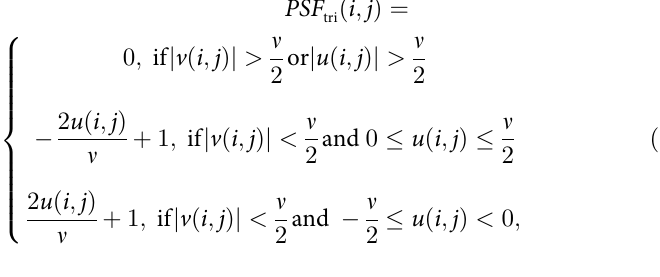
Table 1. Characteristics of MODIS bands and correspondence with reference ASTER